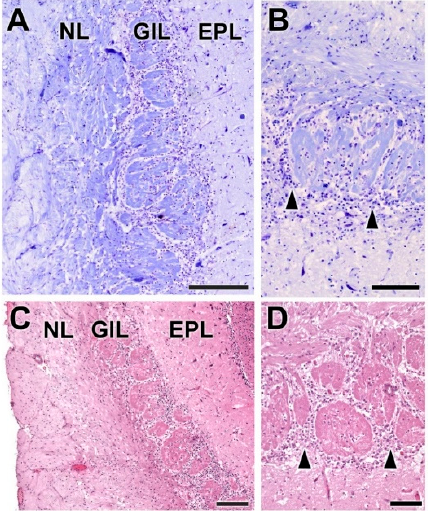
Figure 12. Histological study of the superficial layers of the olfactory bulb of the wolf. ( A , B ) Nissl staining of the nerve (NL), glomerular (GlL) and external plexiform (EPL) layers. The arrowheads indicate the presence of periglomerular cells. ( C , D ) Hematoxylin–eosin staining. The periglomerular cells are mainly located in the border between the glomeruli and the EPL (arrowheads). Scale bars: ( A ): 250 µm; ( B ): 125 µm; ( C , D ): 100 µm.